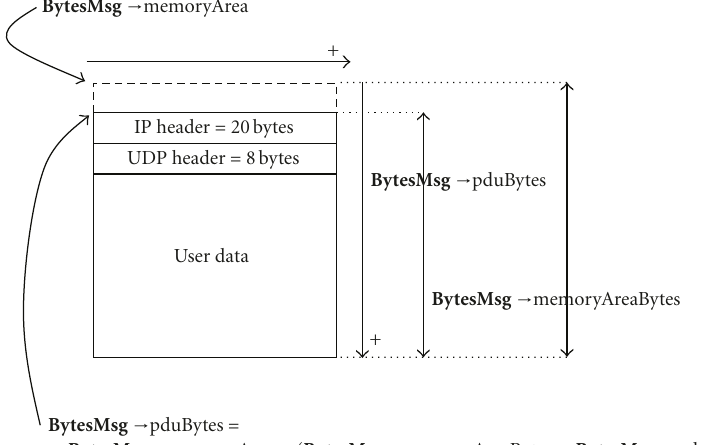
Figure 2: Example of Application Programming Interface: transmitting real